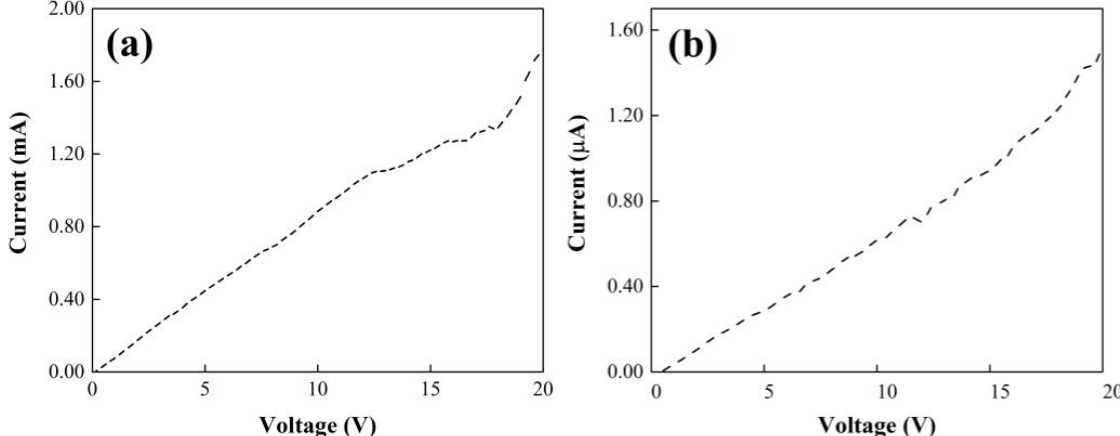
Figure 12. Current as function of voltage for composite yarns of P(S:AN) 50:50 at different CNTs dispersions: ( a ) aligned CNTs, 0.5 wt.% and ( b ) agglomerated CNTs, 1.0 wt.%.